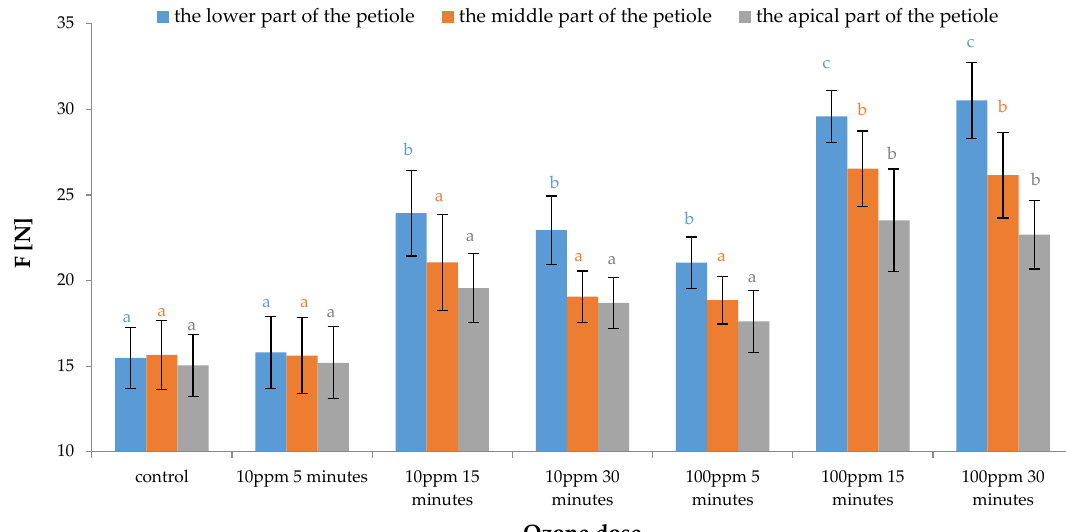
Figure 4. Mean values of destructive force identified for the specimens φ = 4 mm cut out transversely to the axis of rhapontic rhubarb petioles. Differences in the results between the values of the destructive force for individual variants are marked with different small letters, p < 0.05.